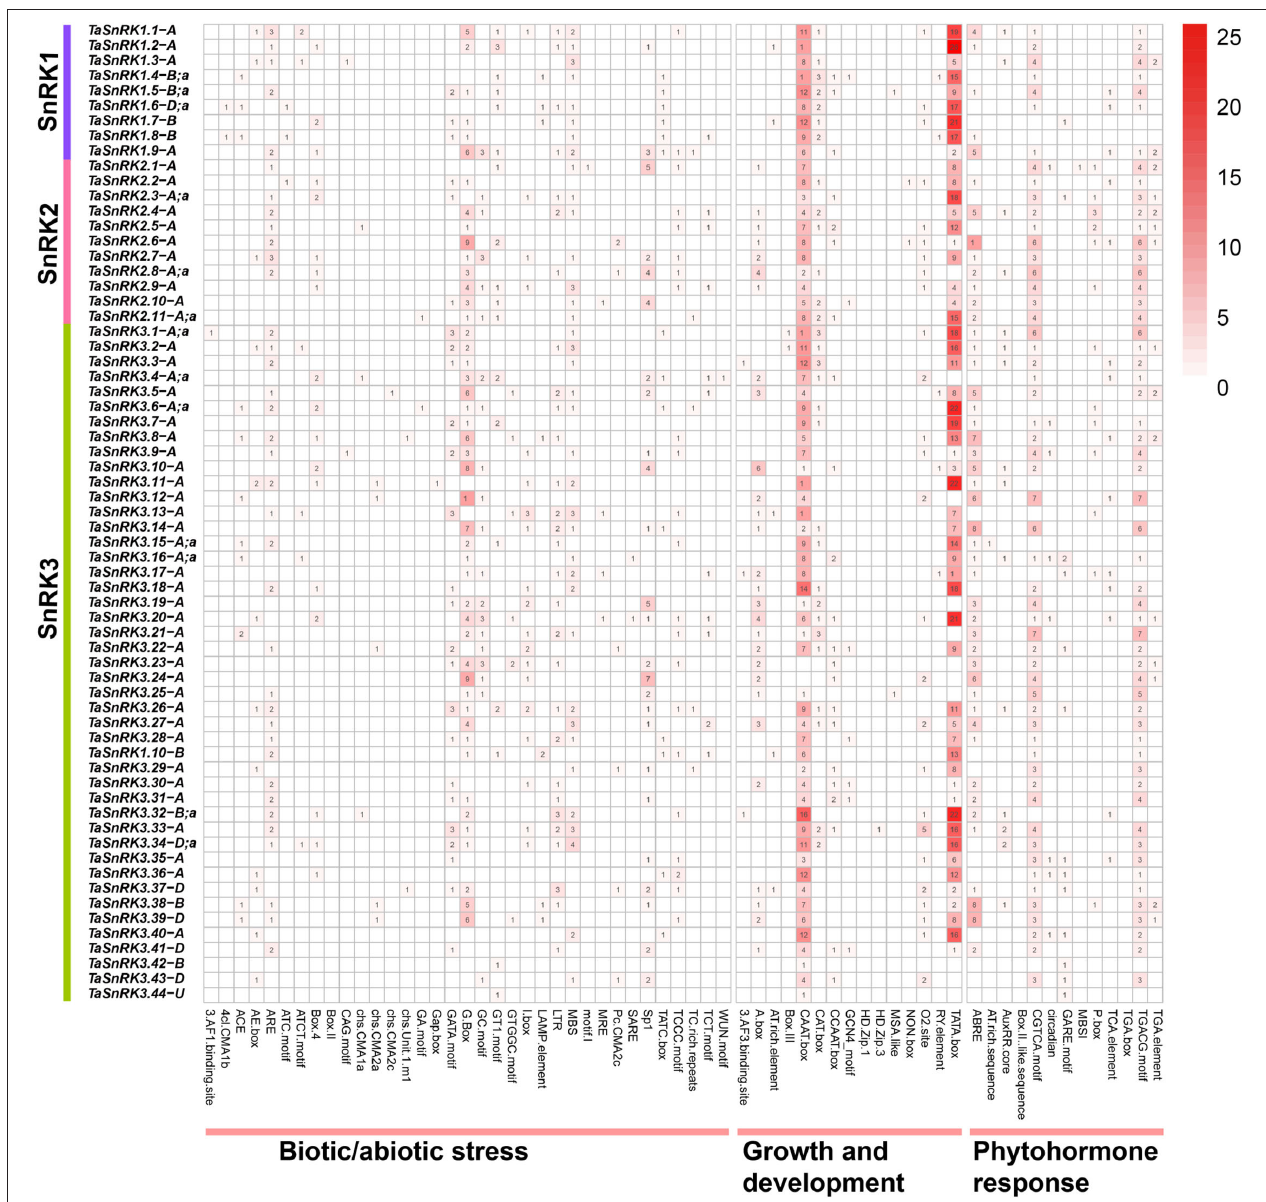
FIGURE 3 | Distribution and summarizing of predicted cis-acting elements in the 1.5kb upstream of 65 representative TaSnRK genes. Cis-acting elements involved in biotic/abiotic stresses, growth and development, and phytohormone response in the promoter of the 65 TaSnRK genes. The different numbers and colors suggest the elements’ numbers. All cis-acting elements of 186 TaSnRKs promoter are displayed in Supplementary Material 6